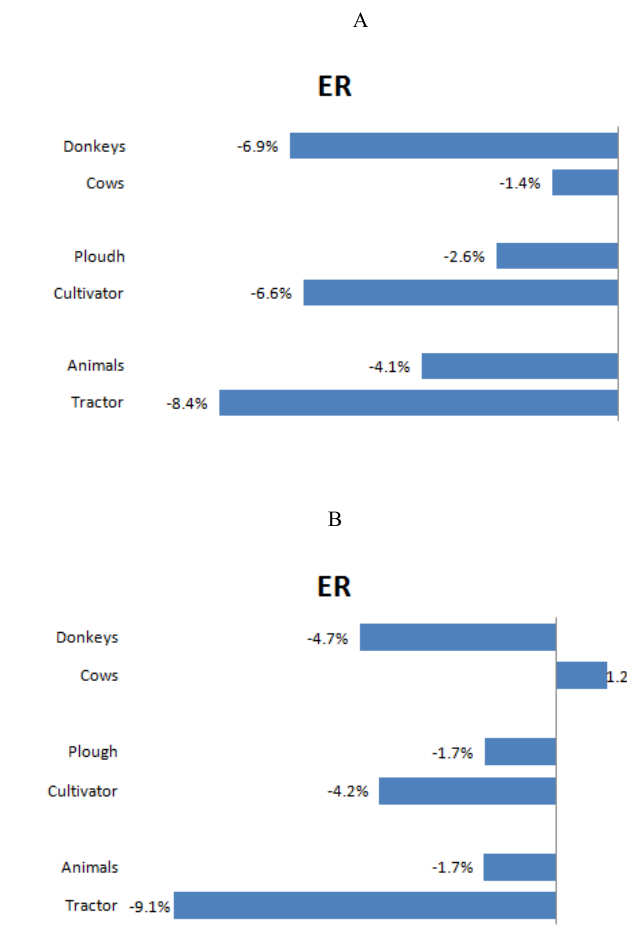
Figure 8: Relative changes in ER after tillage operations (A) at 0.08 m depth (B) and at 0.23